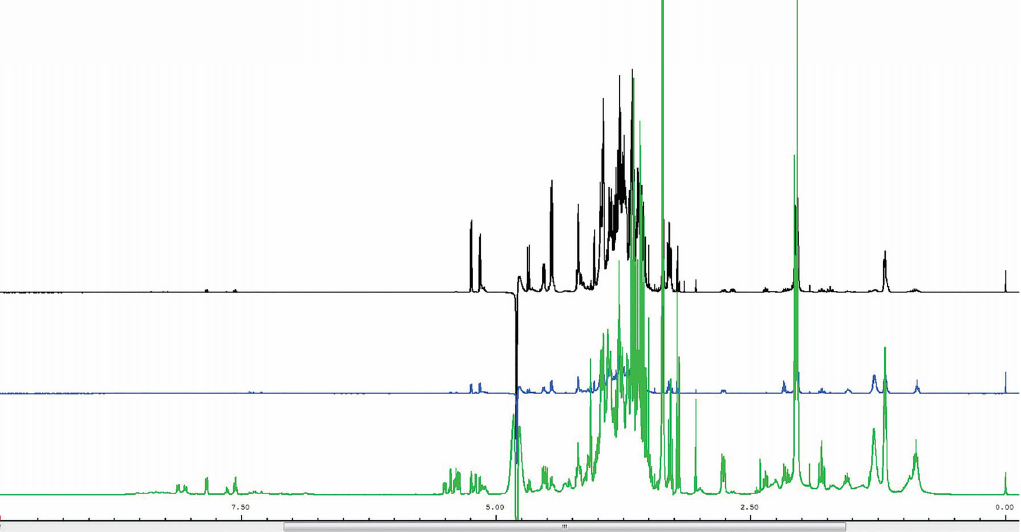
Figure 1. 1 H-NMR spectra of African elephant milk extracts at 2, 11.8, and 29.5 months of lactation (top to bottom). Table 1. List of the quantified signals and their relative assignment and multiplicity. Peak for Metabolite or Unknown